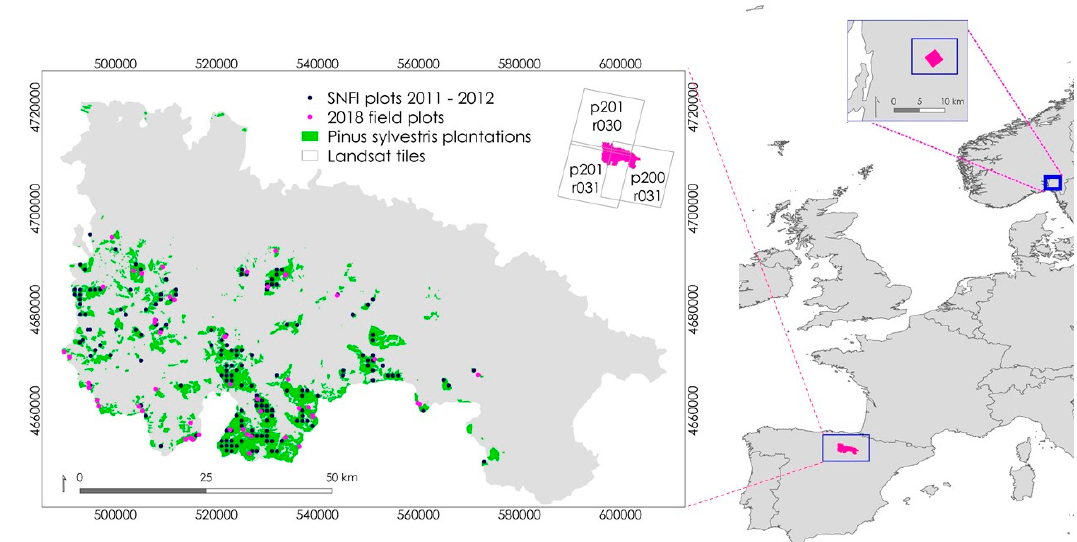
Figure 1. Spanish and Norwegian study areas (small map to the right). Location of sample units in the La Rioja study area (large map to the left). ETRS89/UTM zone 30 N (N-E) (EPSG: 3,042).